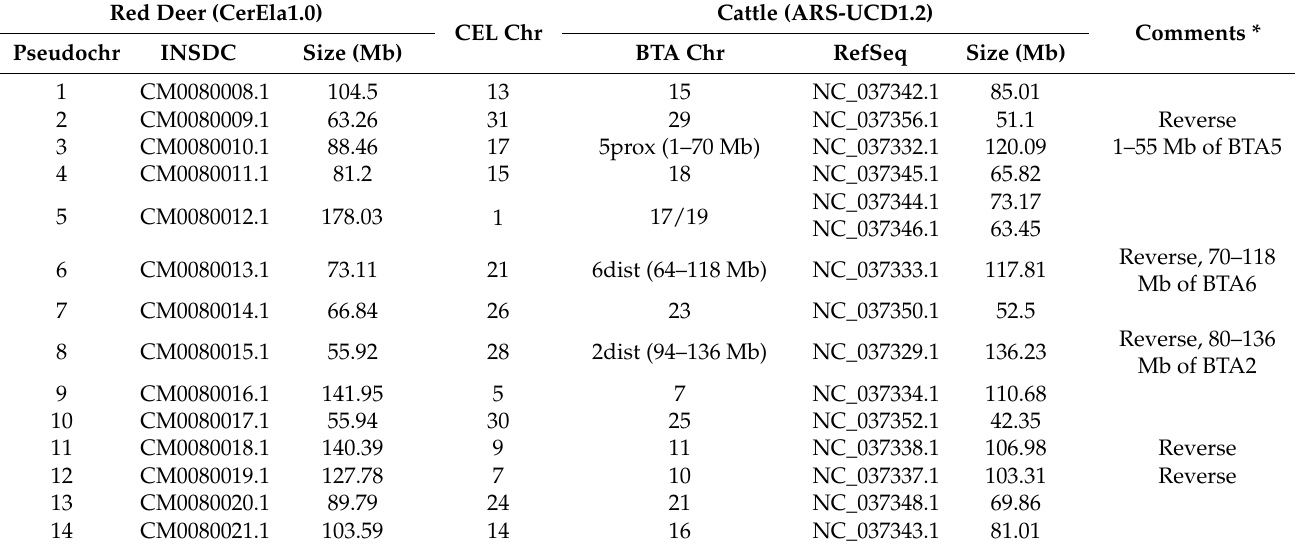
Figure 1. The orthology between the G-banded chromosomes of cattle ( B. taurus , BTA) and red deer ( C. elaphus , CEL). Arrowheads indicate the position of centromeres on the X chromosomes. Table 2. CerEla1.0 and ARS-UCD1.2 genome assembly